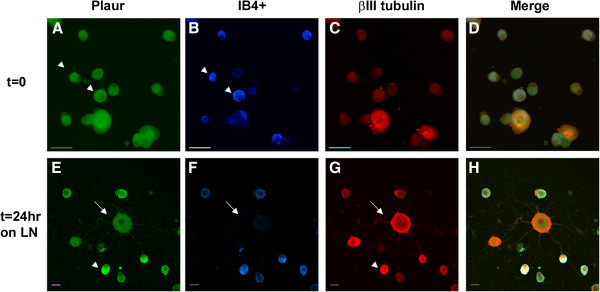
Plaur protein expression in DRG neurons. Dissociated DRG neurons were immunostained for Plaur (green), neuron-specific βIII tubulin (red) and IB4 lectin labeling (blue) at t=0 (A-D) and t=24LN (E-H). While both IB4+ and IB4- neurons express Plaur, densitometric analyses (see Supp. Fig 2) showed that the expression was higher in the IB4+ cells. Scale bar-A-D, 50 μm; E-F, 20 μm.